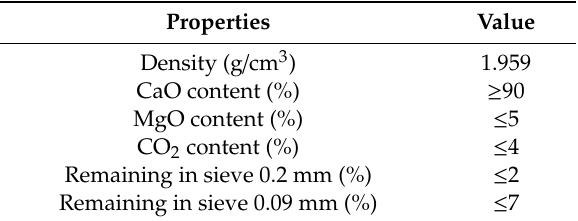
Table 2. Physical and chemical properties of hydrated lime (HL).